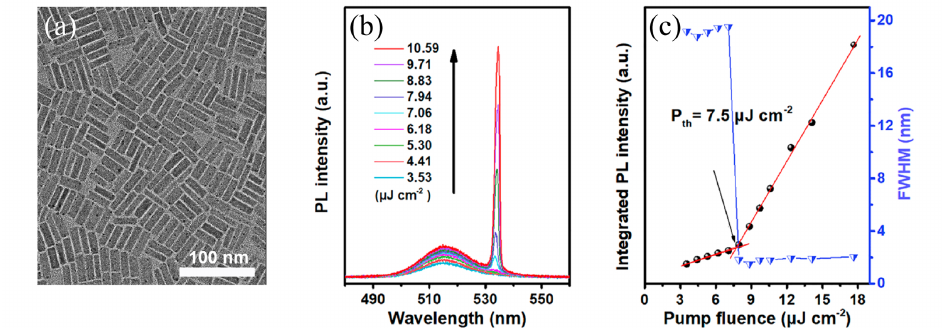
Figure 3. ( a ): TEM image of CsPbBr 3 nanorods. ( b ): excitation density dependence of the PL spectra. ( c ): Excitation density dependence of PL spectrum intensity and linewidth. Adapted with permission from [38]. American Chemical Society, 2019. Table 1. ASE properties of the perovskites described in this review. The data are grouped according to the active material and in order of increasing pump pulse time length. For papers discussing multiple samples with the same material the reported data are relative to the sample with the minimum threshold. Peak wav. Pump Pulse Pump Active Material